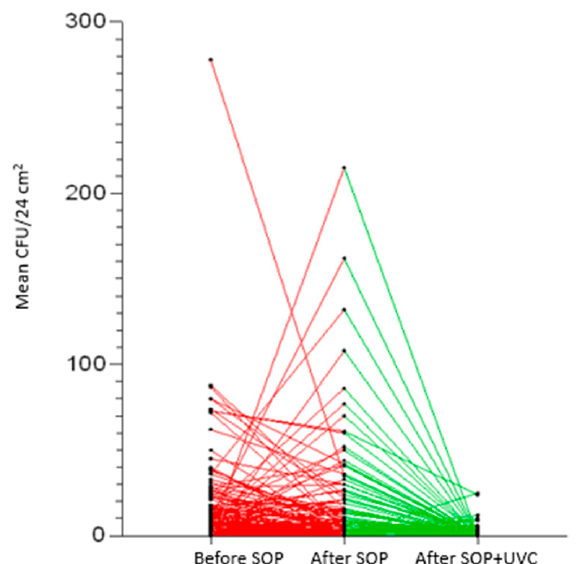
Figure 1. Total viable counts (TVCs) reduction chart after each treatment. In red the variation of the TVCs between before and after SOP; in green the variation of the TVCs between after SOP and after SOP+UV-C.